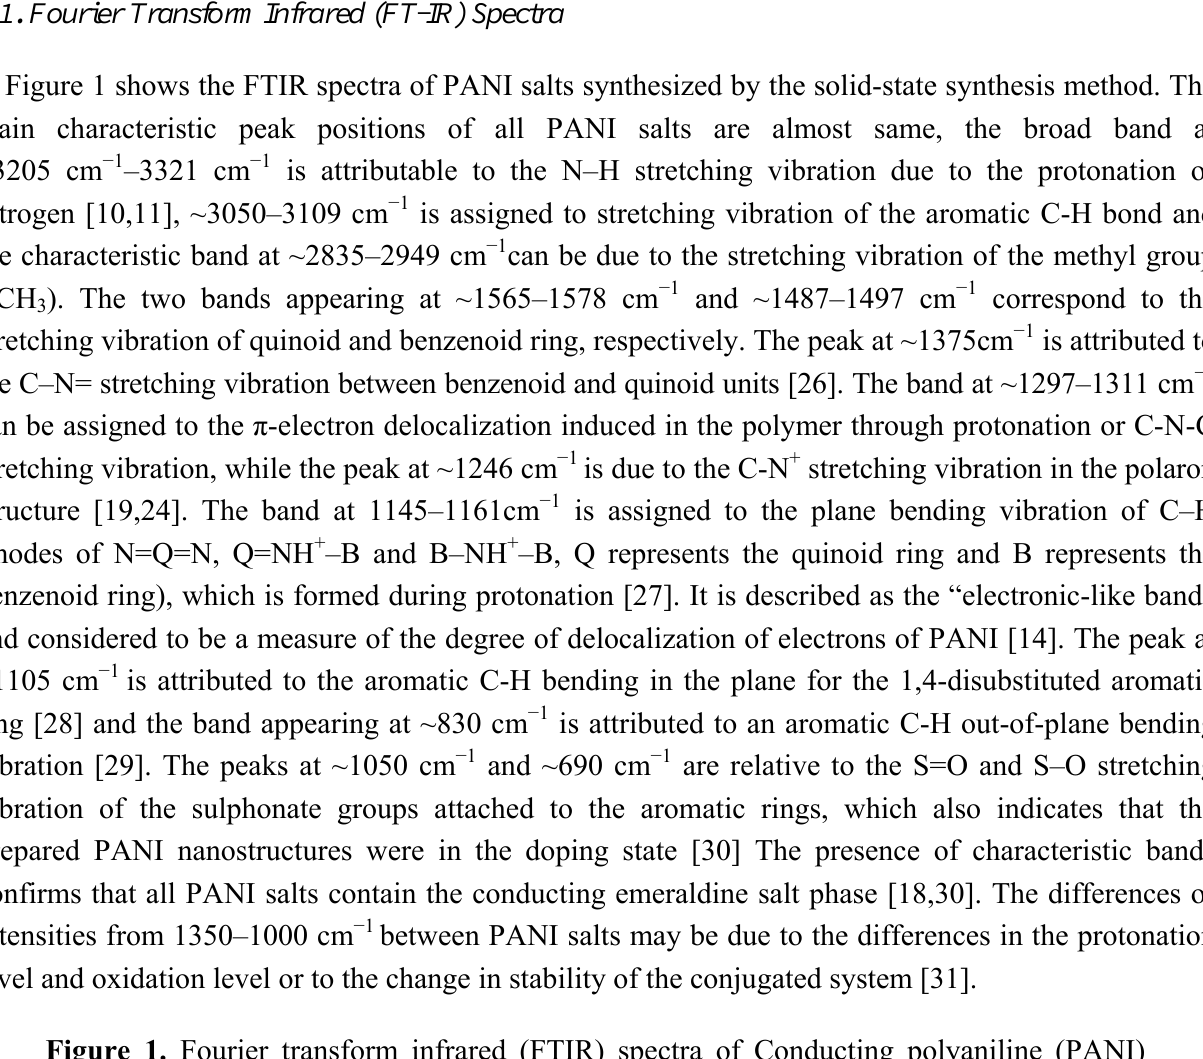
Figure 1. Fourier transform infrared (FTIR) spectra of Conducting polyaniline (PANI) with different amounts of